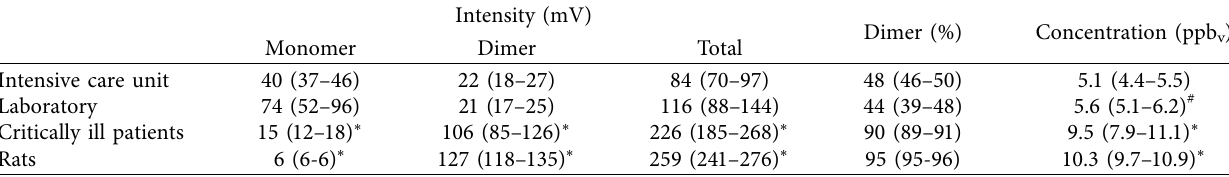
Table 1: Monomer, dimer, and total acetone intensity (mV).